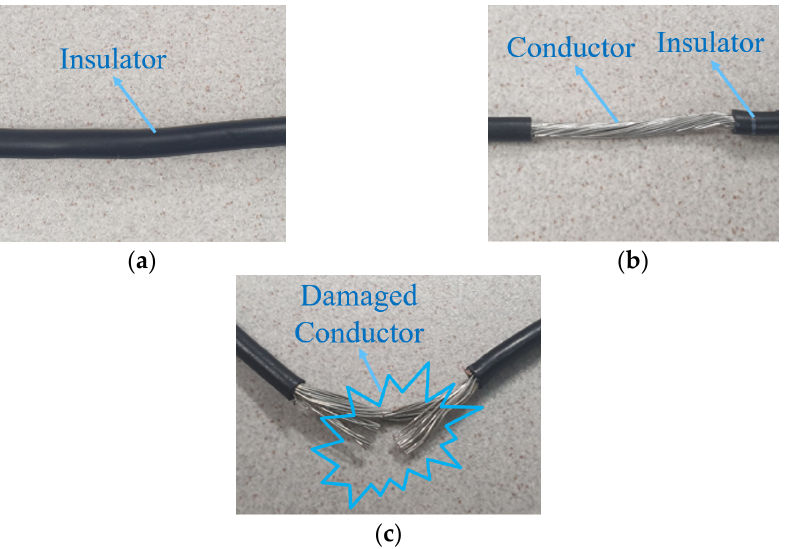
Figure 6. The process of inducing damage into the wires: ( a ) Healthy wire inside the cable; ( b ) Insulator-removed wire; ( c ) Faulty wire with a damaged conductor (some strands are cut). To simulate the fault conditions with varying rotational speed, rotational direction, and load torque, the third joint of the manipulator was controlled to move up and down repeatedly, as shown in Figure 7. The motor in that joint is controlled by the controller to